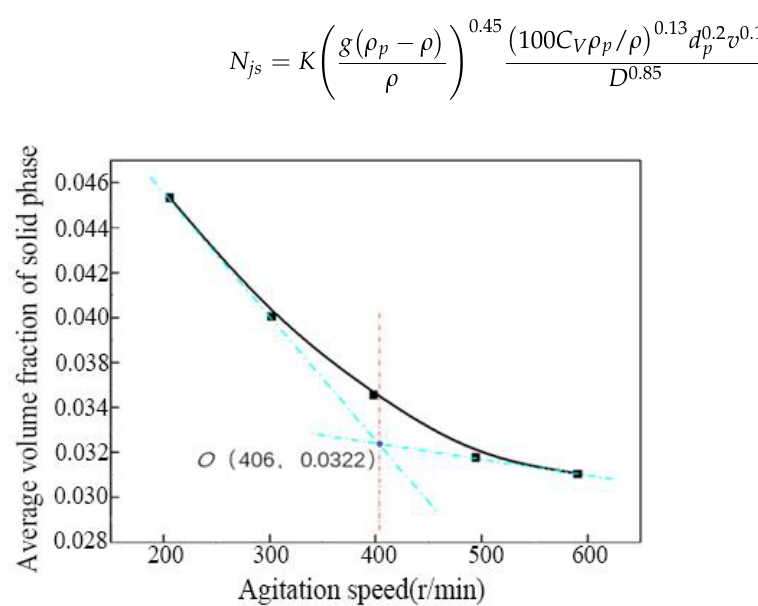
Figure 7. Average solid volume fraction at the bottom of the autoclave. With the increase in stirring speed, the average solid-phase volume fraction in the bottom area of the autoclave decreased. Then, make the maximum slope and the minimum slope tangent, and from the figure, it can be found that the coordinates of the intersec- tion point O is (406, 0.0322). Therefore, the critical suspension speed of the autoclave is N sp = 406 rpm. Take the shape factor of the autoclave as K = 1.4, the solid-phase particle density is 2000 kg/m 3 , the diameter is 0.1 mm, the solid holdup is C v = 0.042, the blade diameter is 0.1 m, and the dynamic viscosity of water is 1.005 × 10 − 3 N · s/m 2 . After calcula- tion, the result obtained is N js = 432 rpm, which is slightly higher than the simulated